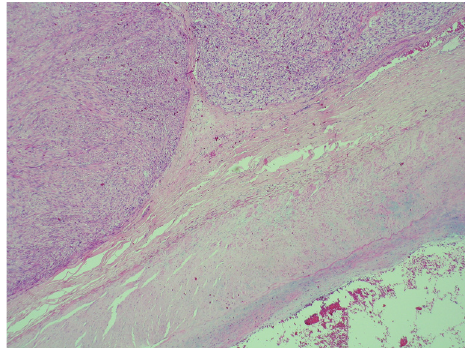
Figure 3: Miscroscopic picture of leiomyosarcoma arising from major blood